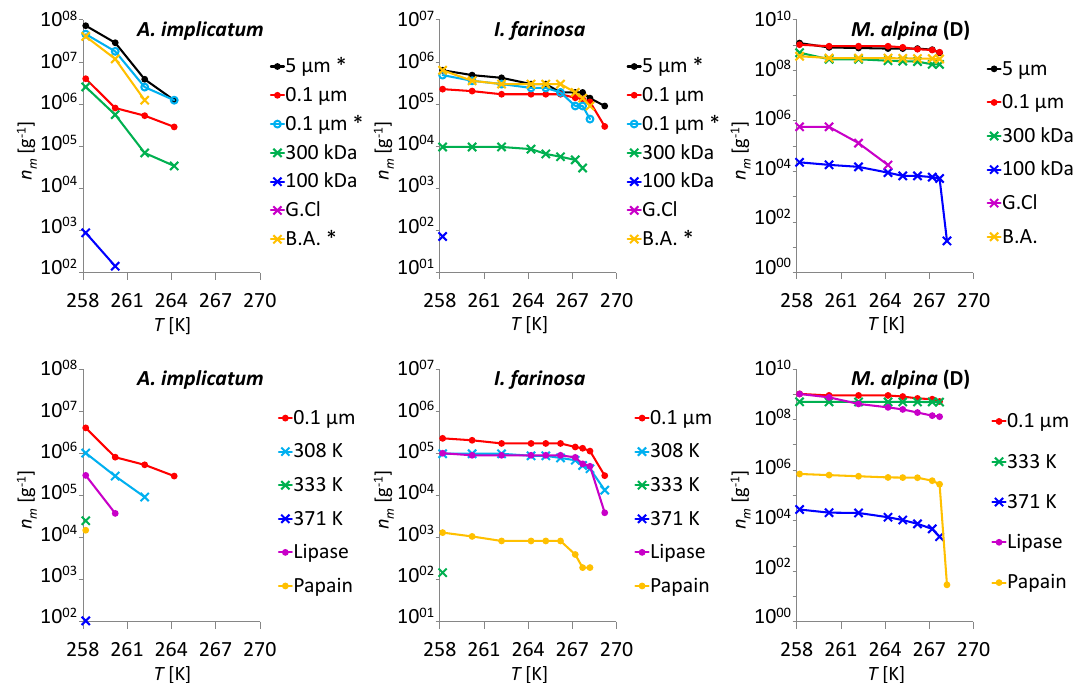
Figure 2. n m (T ) -curves for A. implicatum , I. farinosa , and M. alpina (subgroup D) INMs after different treatments. G.Cl stands for guani- dinium chloride treatment, and B.A. for boric acid treatment. A reduction of n m suggests that this method partly or fully destroyed the INMs. The absence of data points despite the listing in the figure legend indicates that n m lied below the detection limit. For M. alpina , the data are the mean curves of all investigated strains of the phylogenetic subgroup D, which is the most representative (Fröhlich-Nowoisky et al., 2015). The ∗ symbol for A. implicatum and I. farinosa values: these measurements were undertaken with the filtrates of another harvest, which explains the higher values in comparison to the other results.